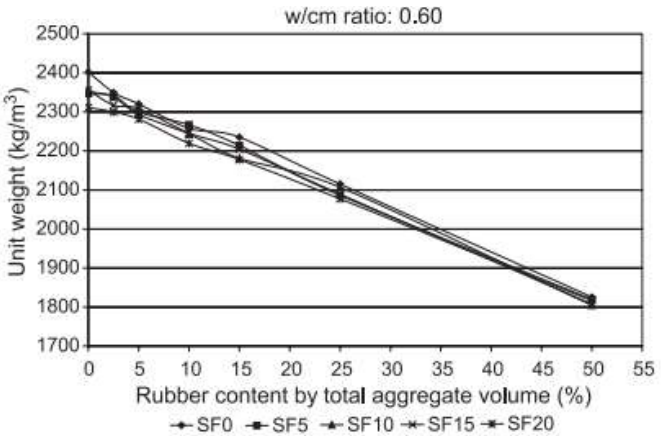
Figure 19. Influence of rubber and silica fume content on unit weight of concrete [62].